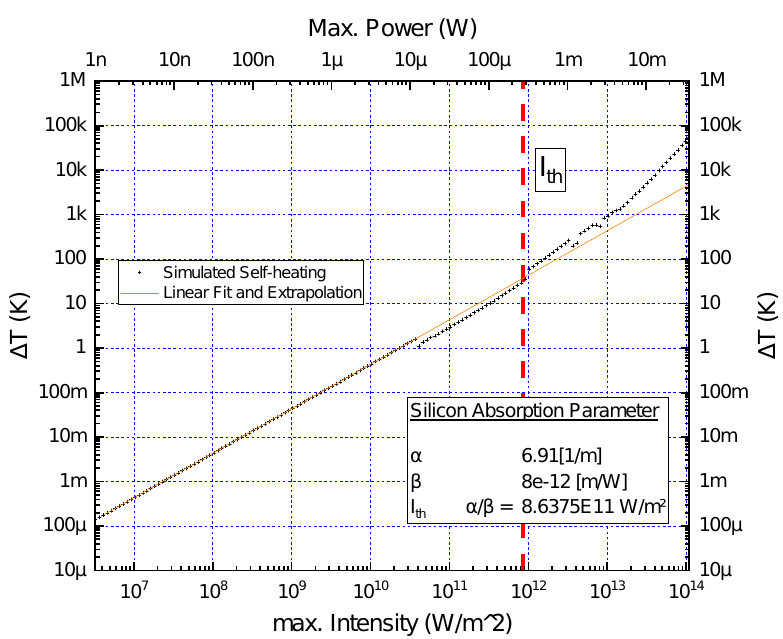
Figure 6. Simulation of the self-heating of the nanobeam design (Silicon) versus the maximum intensity and power within the optical cavity. Below the threshold intensity I th = α / β , linear absorption dominates the self-heating effect, while at higher intensities the nonlinear two-photon absorption becomes more